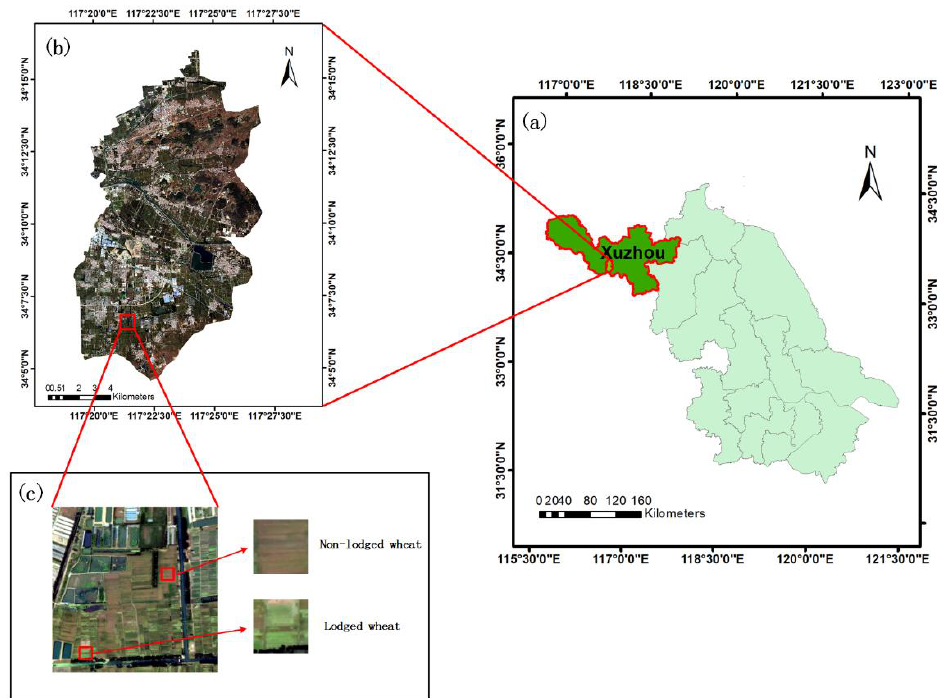
Figure 1. Illustration of the study area: ( a ) administrative regions of Jiangsu Province and Xuzhou City; ( b ) administrative regions of Zhangji Town and the distribution of wheat cultivation; ( c ) typical wheat lodging areas.